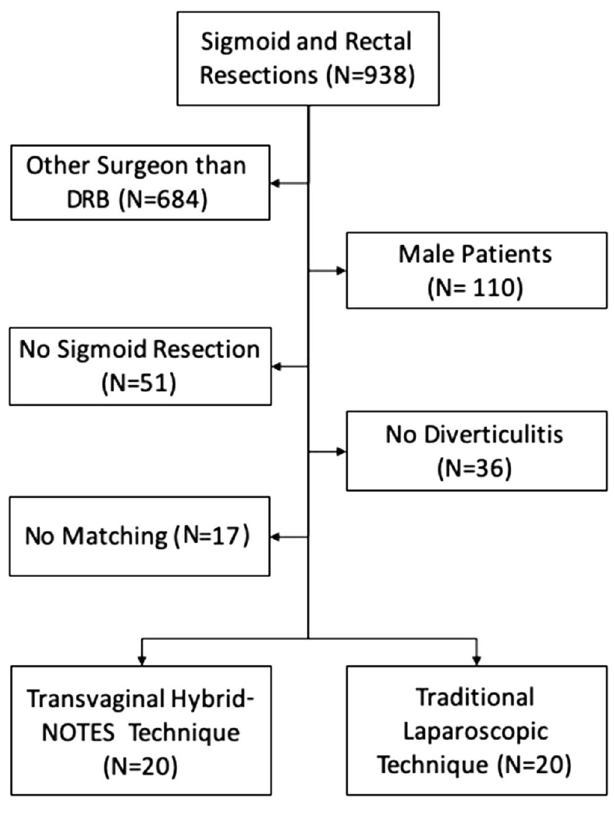
Figure 1. Trial flow